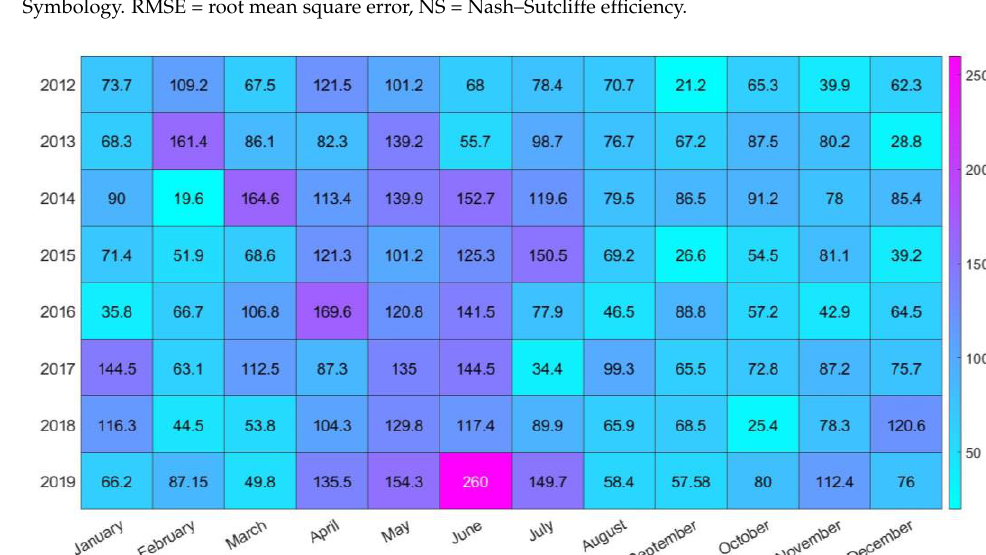
Symbology. RMSE = root mean square error, NS = Nash–Sutcliffe efficiency.